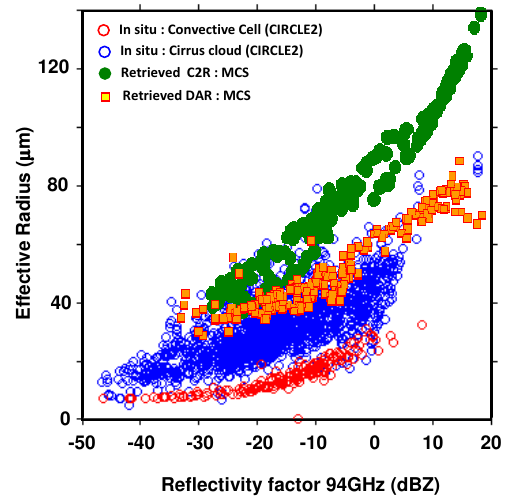
Fig. 9. Same as Fig. 8. R eff - Z